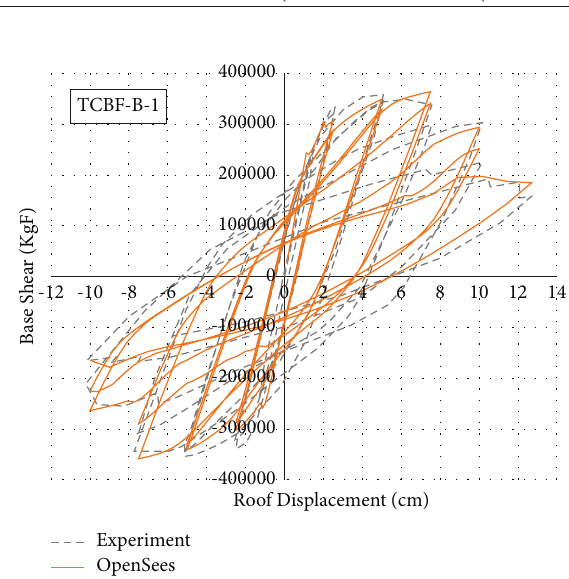
Figure 10: Experimental and numerical validation.